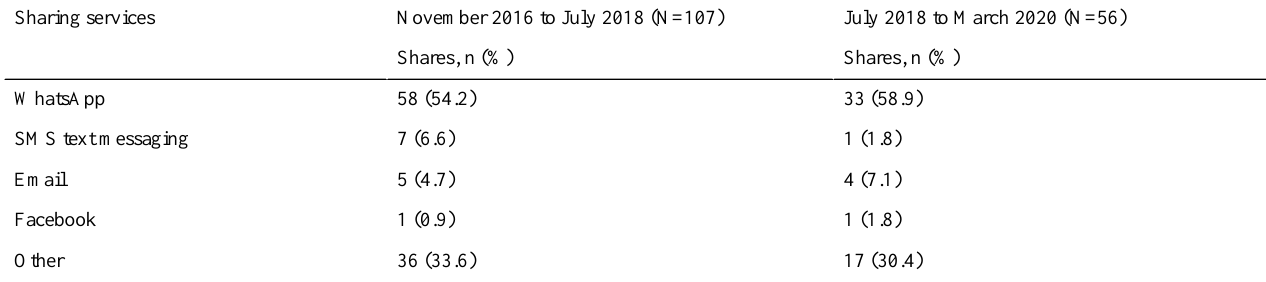
Table 4. Use of sharing services during both study